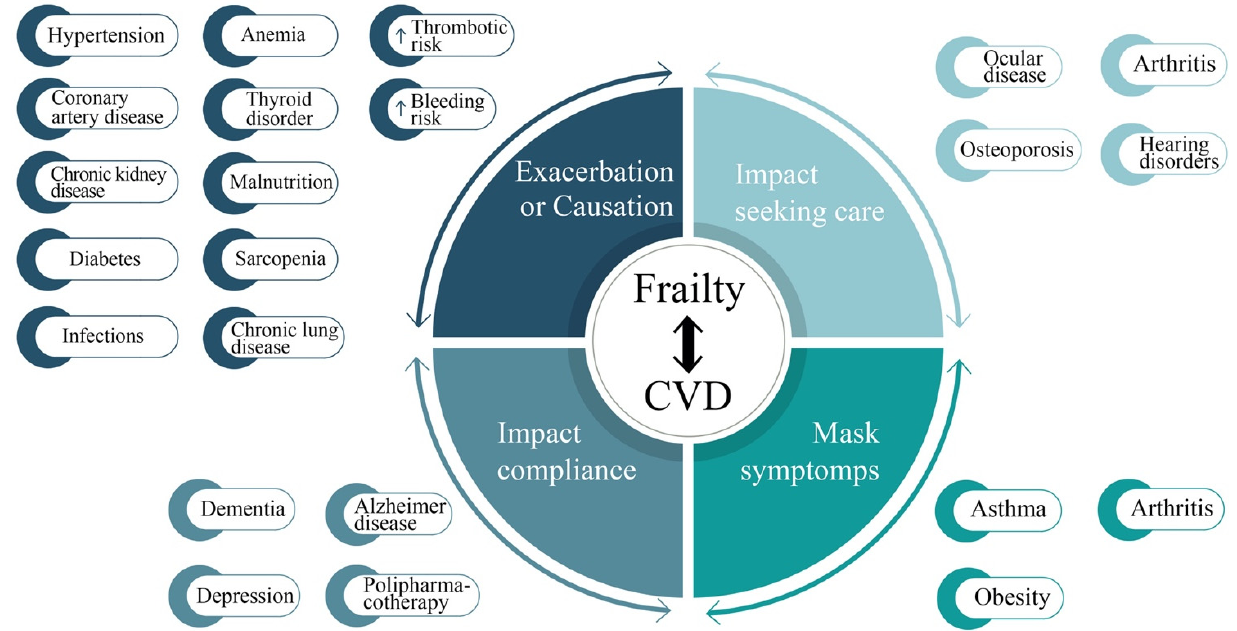
Figure 1. Principal comorbidity overlapping frailty and cardiovascular disease in elderly patients. CVD, cardiovascular disease; , increase of.